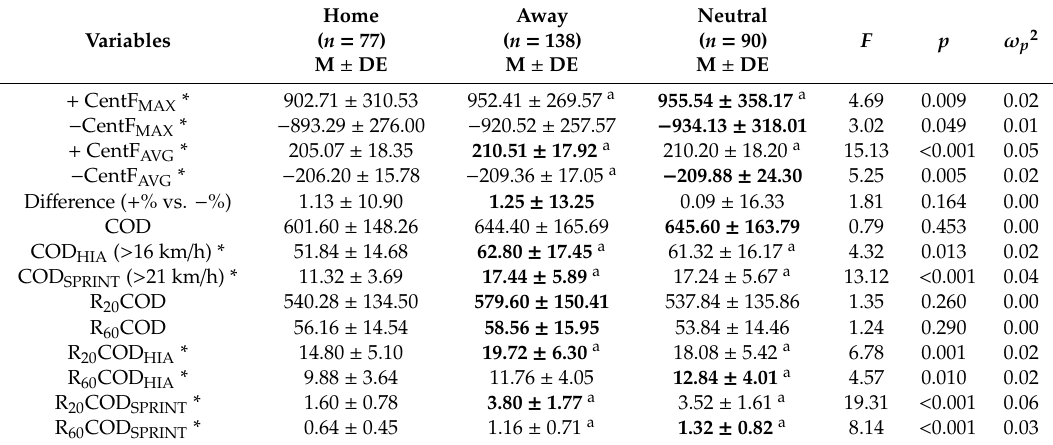
Table 3. Descriptive and comparative analysis of centripetal force and changes of direction related to the match